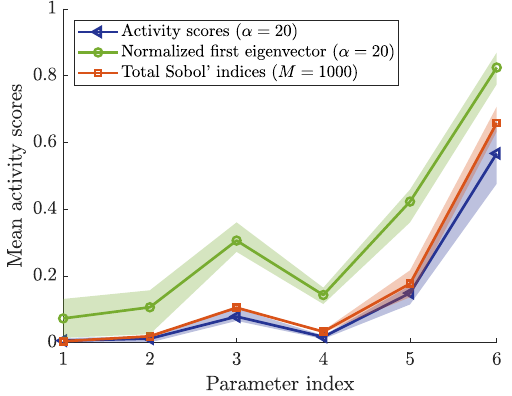
Figure 12. Normalized activity scores, first eigenvector entries, and Sobol’ indices for the bottleneck scenario. The parameter index is mapped as follows: 1—control parameter, 2—free-flow speed mean, 3—free-flow speed standard deviation, 4—number of agents, 5—bottleneck width, 6—personal space